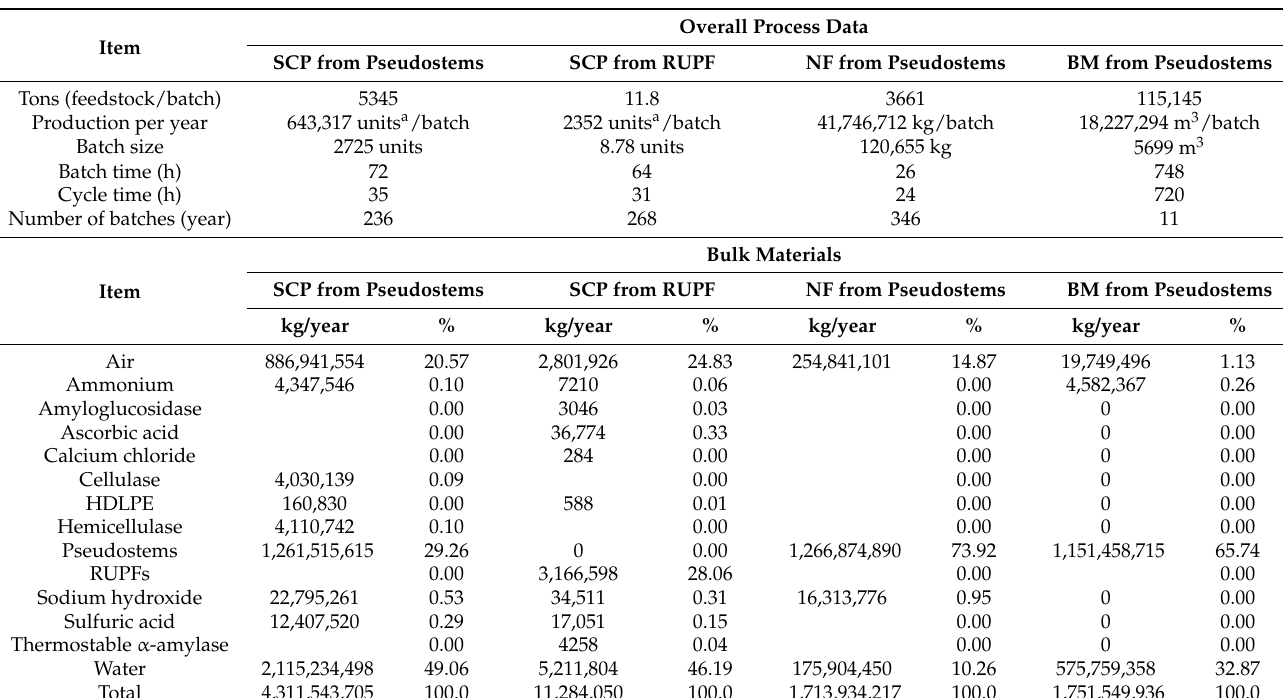
Table 7. Overall process data and global mass balance for the simulated process